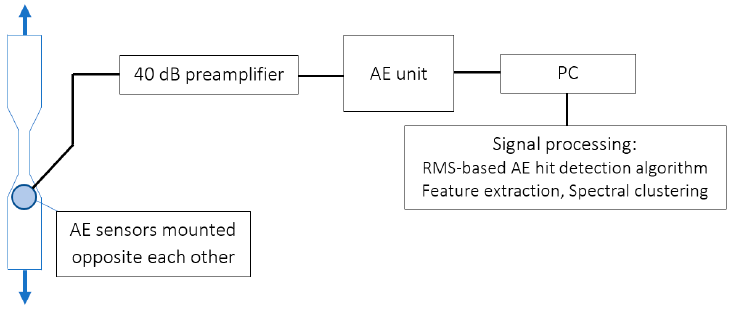
Figure 2. Schematic diagram of the experimental setup.